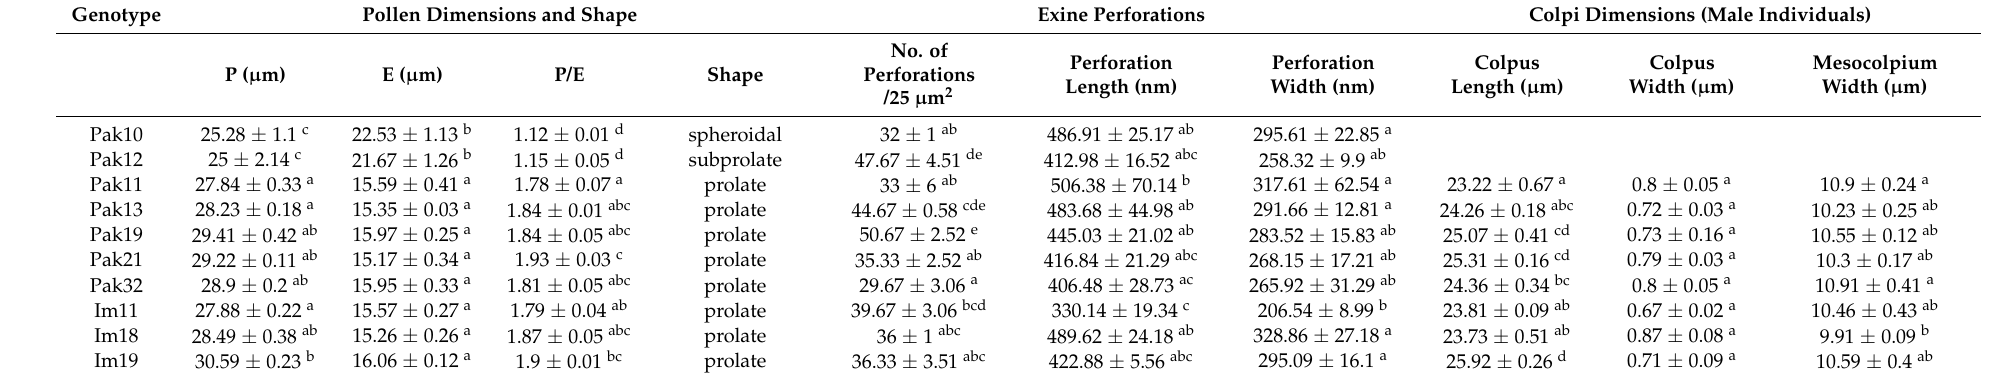
Table 1. Morphometric data on pollen grains taken from 10 V. sylvestris genotypes (two female and eight male) from two different natural populations. Each value represents an average measurement ± standard deviation, based on a minimum of 30 pollen grains per genotype obtained by the scanning electron microscopy